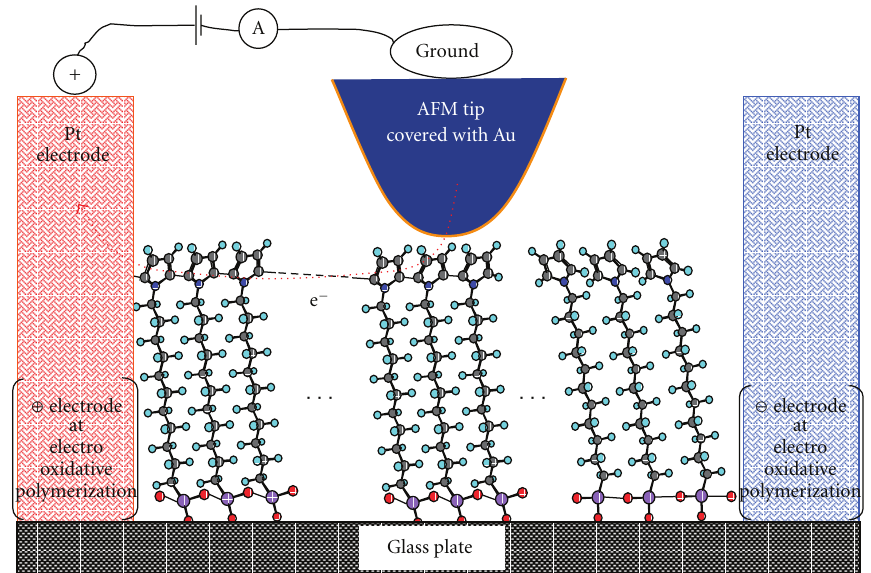
Figure 8: A possible electric conduction path at the current measurement shown schematically. Wherein the polypyrrolyl conjugated bonds contributing to the electric conduction in the PNN monomolecular layer are schematically shown at the molecular level. The direction of the electron running is shown by a broken